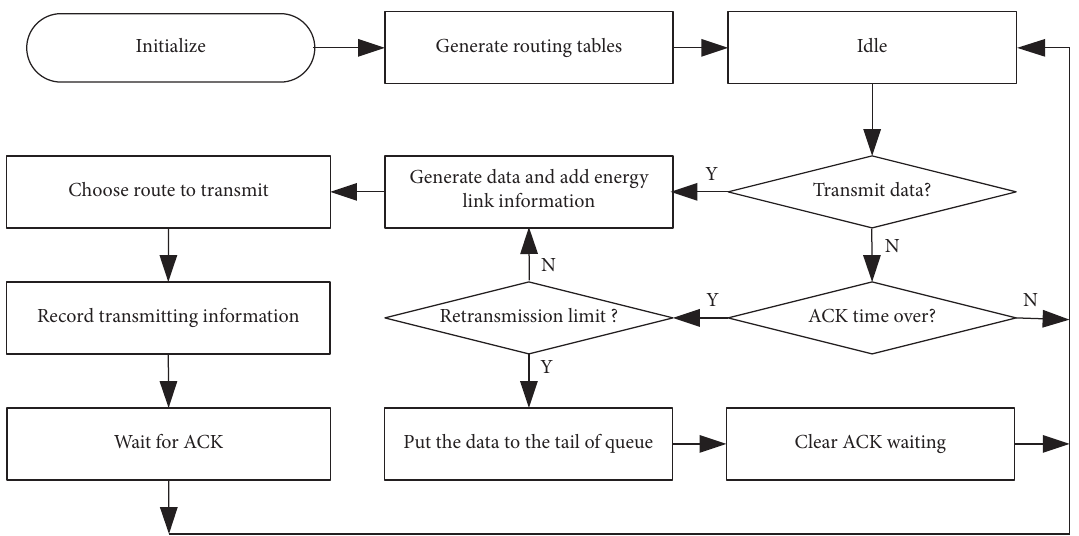
Figure 2: Flowchart of the transmitting terminal.